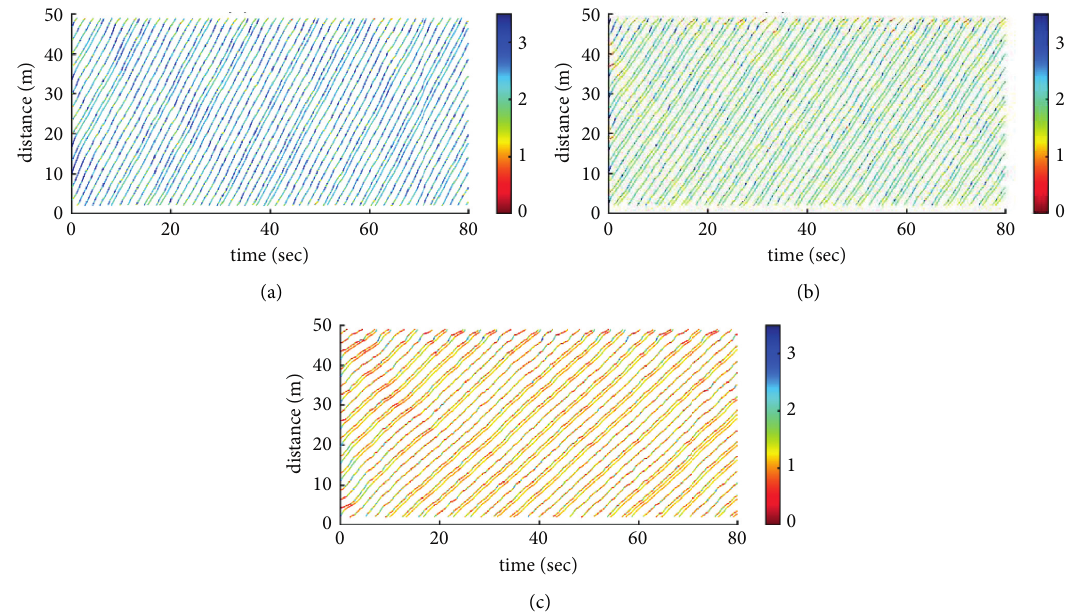
Figure 7: Each bicycle’s trajectory on the middle lane in Case III, where the fixed numbers of bicycles on each lane in (a), (b), and (c) are, respectively, 15, 19, and 23. (a) N � 15. (b) N � 19. (c) N �